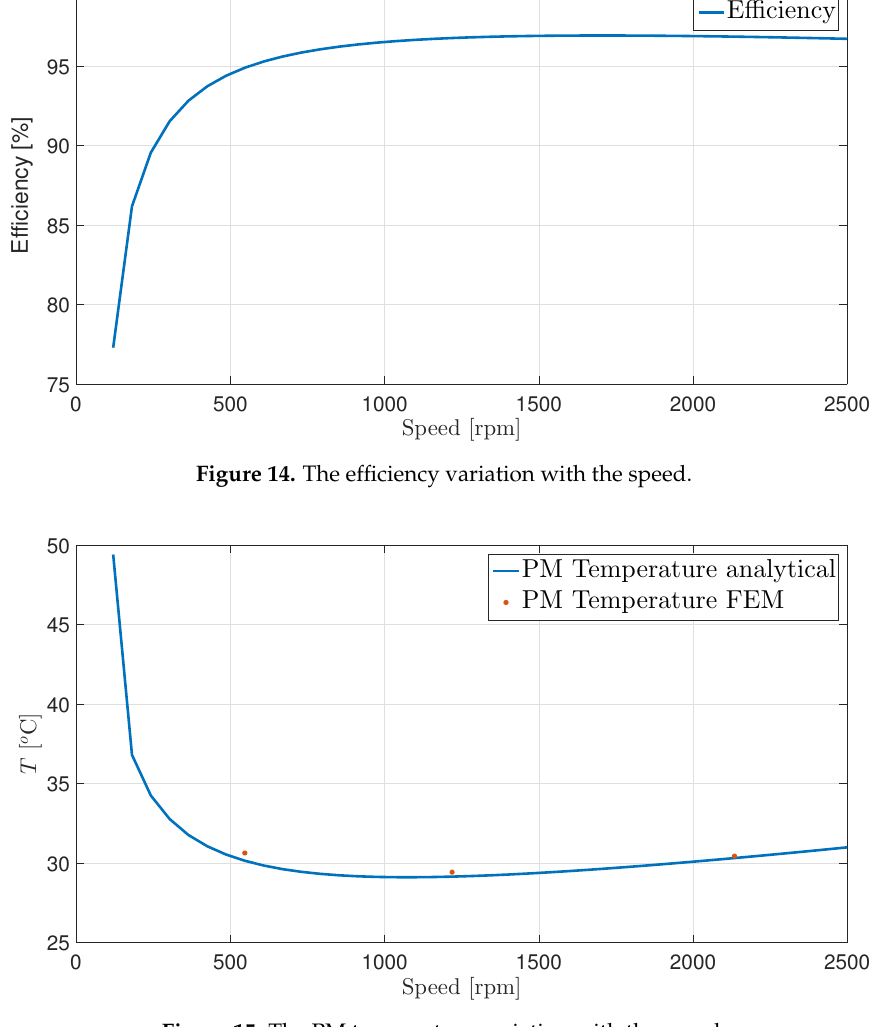
Figure 15. The PM temperature variation with the speed.